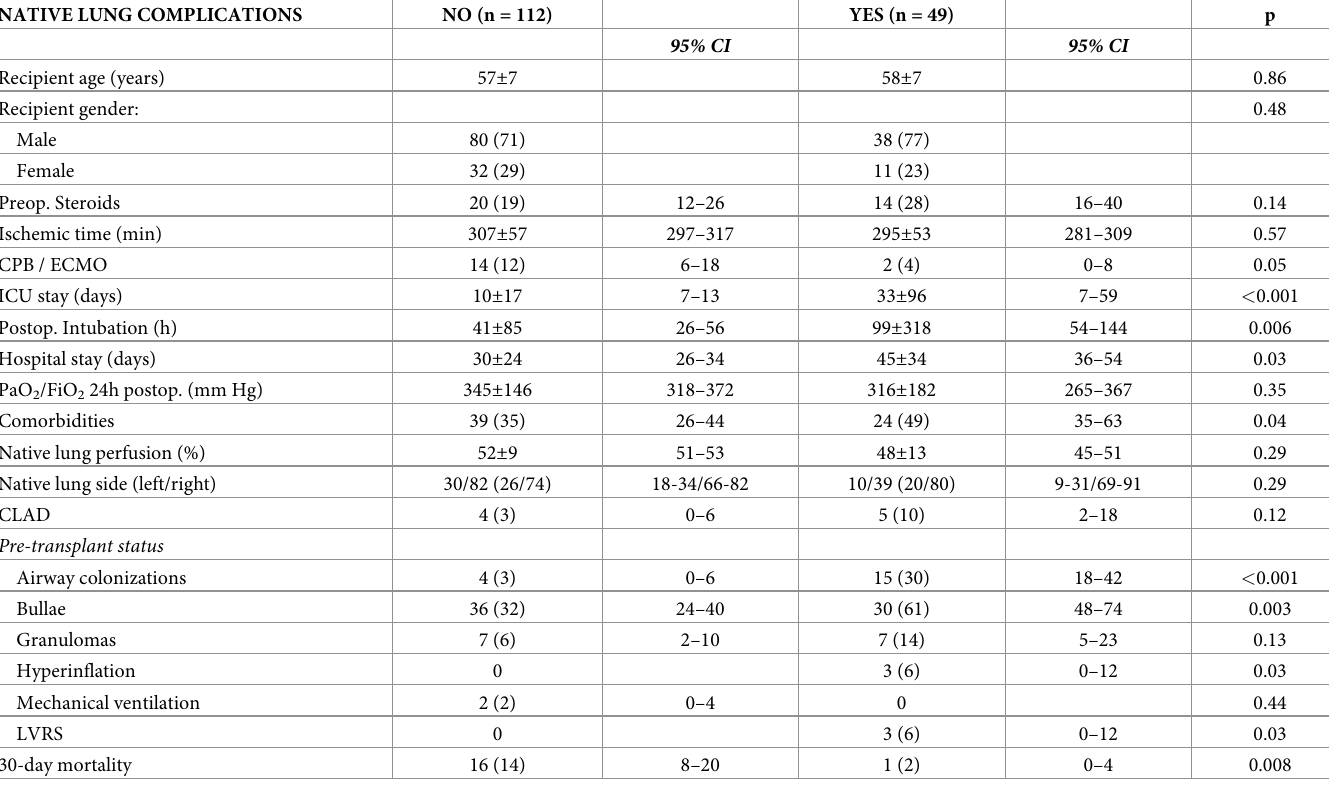
Table 2. Comparative data between patients with and without native lung complications following single lung transplantation (overall group). NATIVE LUNG COMPLICATIONS NO (n = 112) YES (n = 49) p 95% CI 95%